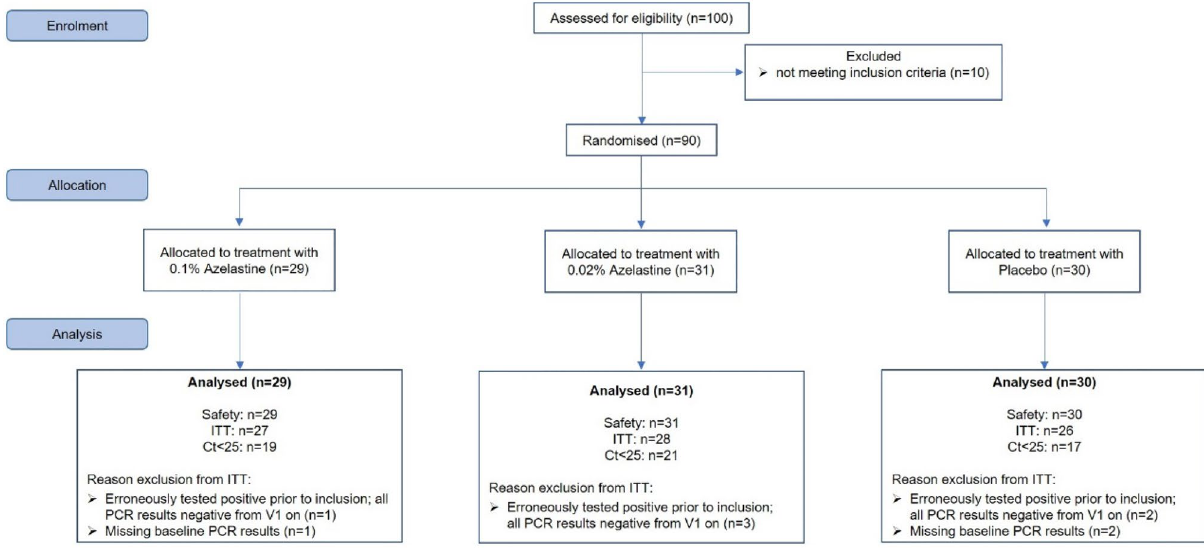
Figure 1. Patient disposition. ITT—intention to treat. Ct—cycle